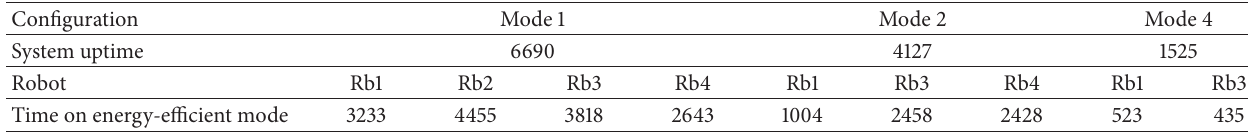
Table 1: Time of robots on their energy-efficient